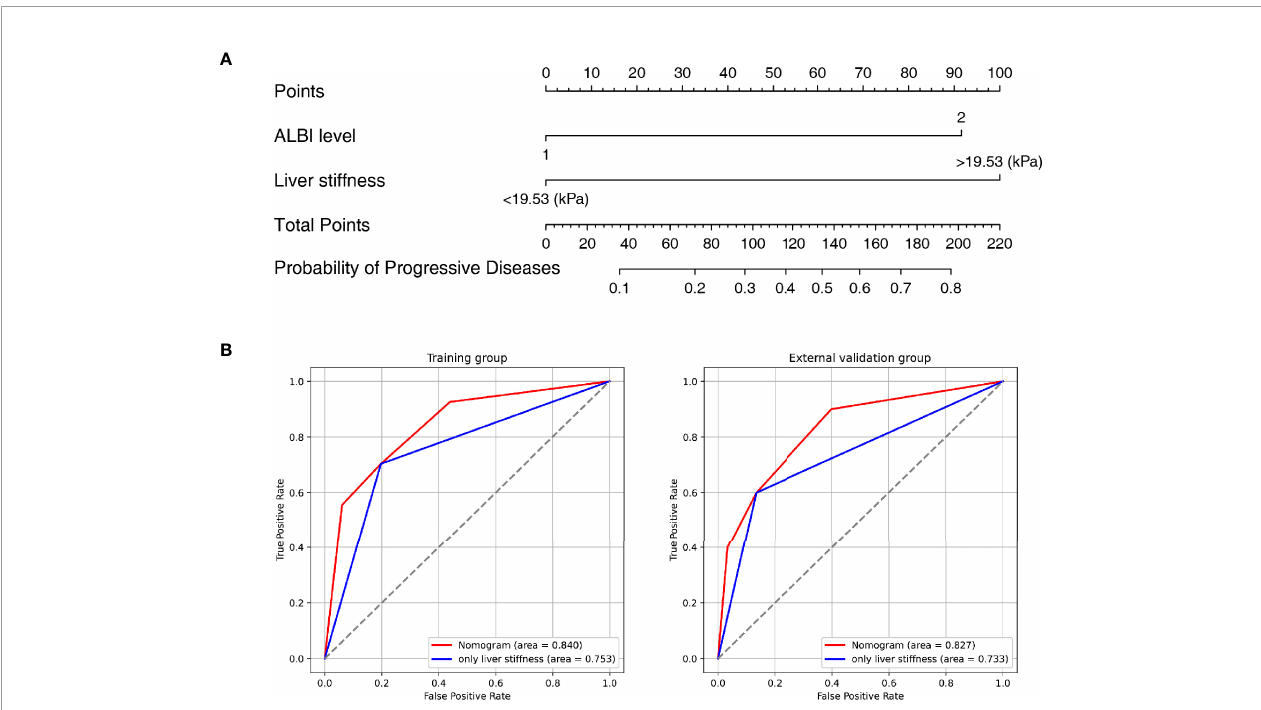
FIGURE 3 | Nomogram and Receiver operating characteristic (ROC) curves analysis. (A) Nomogram for predicting probability of Progressive Diseases (PD) after therapy with anti – programmed cell death protein 1 (PD-1) plus lenvatinib. (B) ROC curves for 2 models in the training (left) and validation (right) set. Model based on baseline liver stiffness (LS) values of tumorous foci >19.53 kPa were shown in blue. Nomogram contains both baseline LS of tumorous foci and ALBI grade were shown in